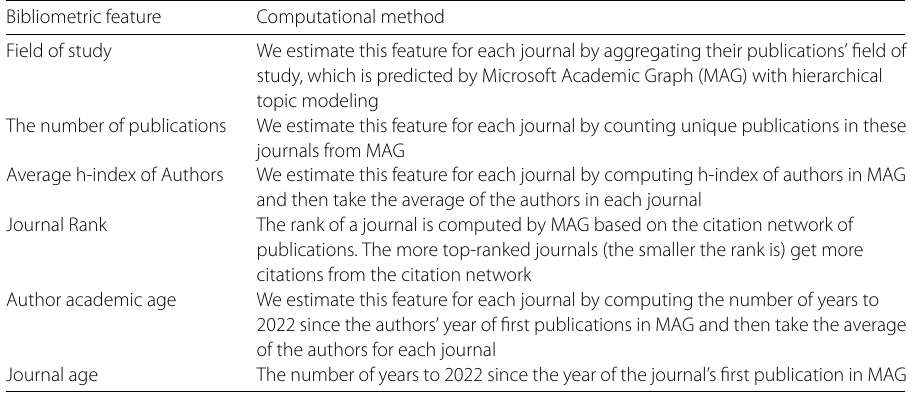
Table 1 bibliometric features explanations and computation methods. We use MAG to produce the features in this